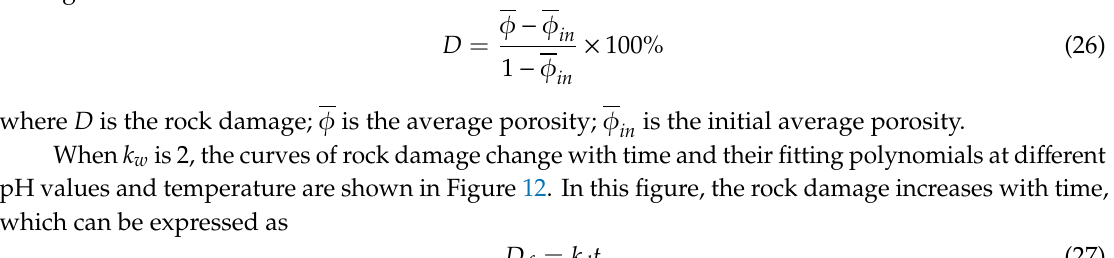
Figure 11. The distribution of fluid velocity at different temperature and time ( k w = 2, pH = 6.6): ( a ) T = 80 ◦ C, 1 × 10 6 s; ( b ) T = 80 ◦ C, 3 × 10 6 s; ( c ) T = 80 ◦ C, 5 × 10 6 s; ( d ) T = 90 ◦ C, 1 × 10 6 s; ( e ) T = 90 ◦ C, 3 × 10 6 s; ( f ) T = 90 ◦ C, 5 × 10 6 s.